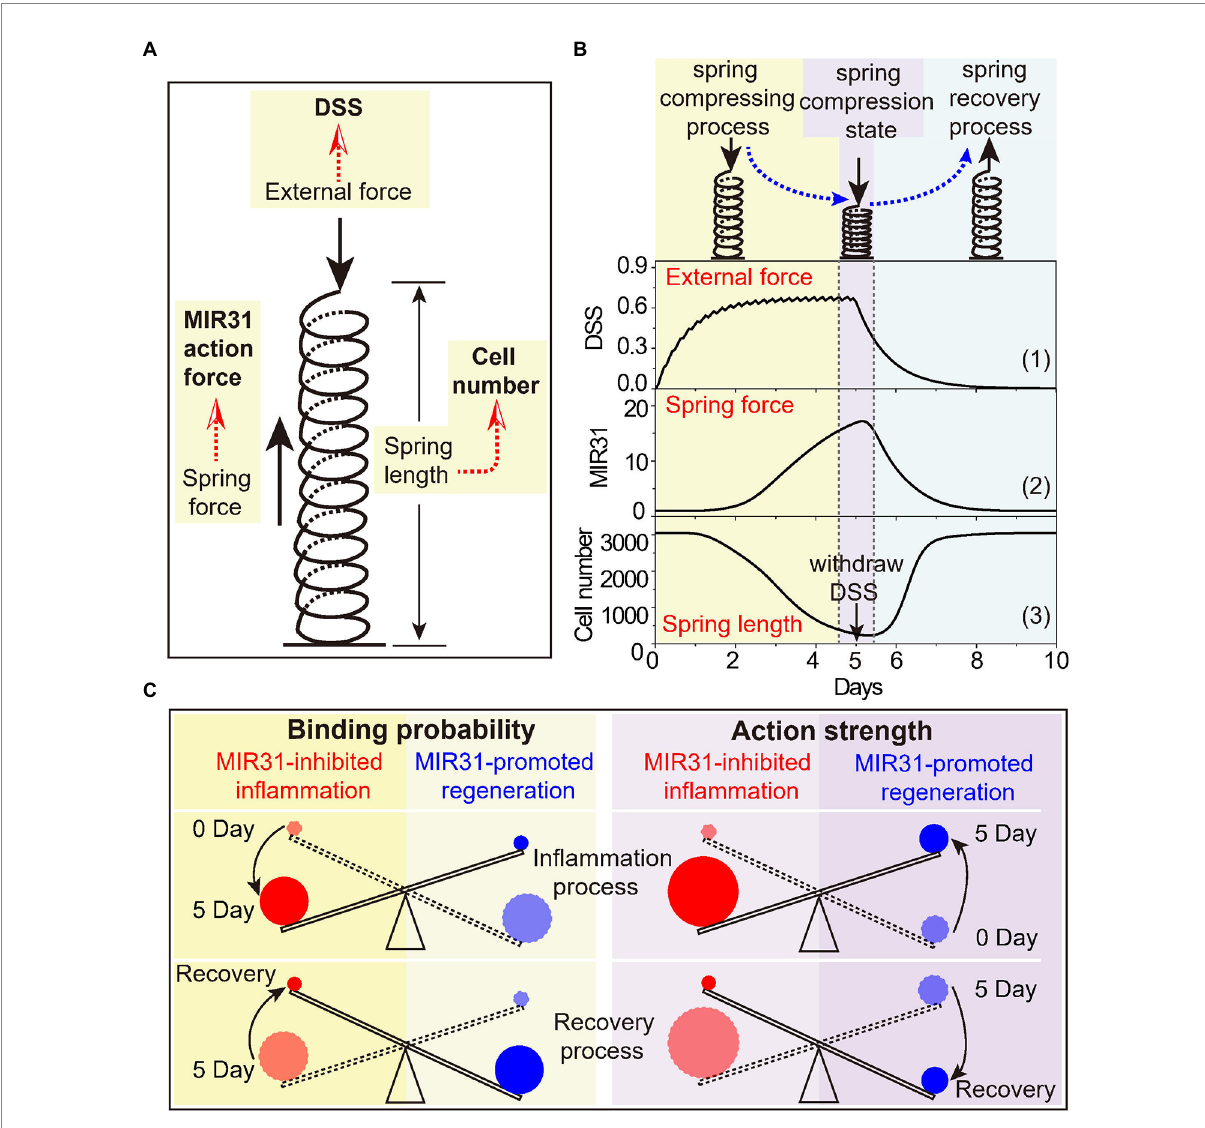
FIGURE 7 The spring-like effect and the seesaw model of MIR31 in balancing inflammatory and regenerative responses. (A) Schematic diagram of the spring-like effect of inflammatory response to DSS treatment. (B) The specific correspondence between the inflammatory response process to DSS and the spring system. Considering the trend of MIR31 expression trend was consistent with that of MIR31 action strength, it was used to characterize the trend of the MIR31 action strength. (C) The seesaw model of MIR31 competition mechanism in the WT model from the viewpoints of the binding probability (left) and the action strength of MIR31